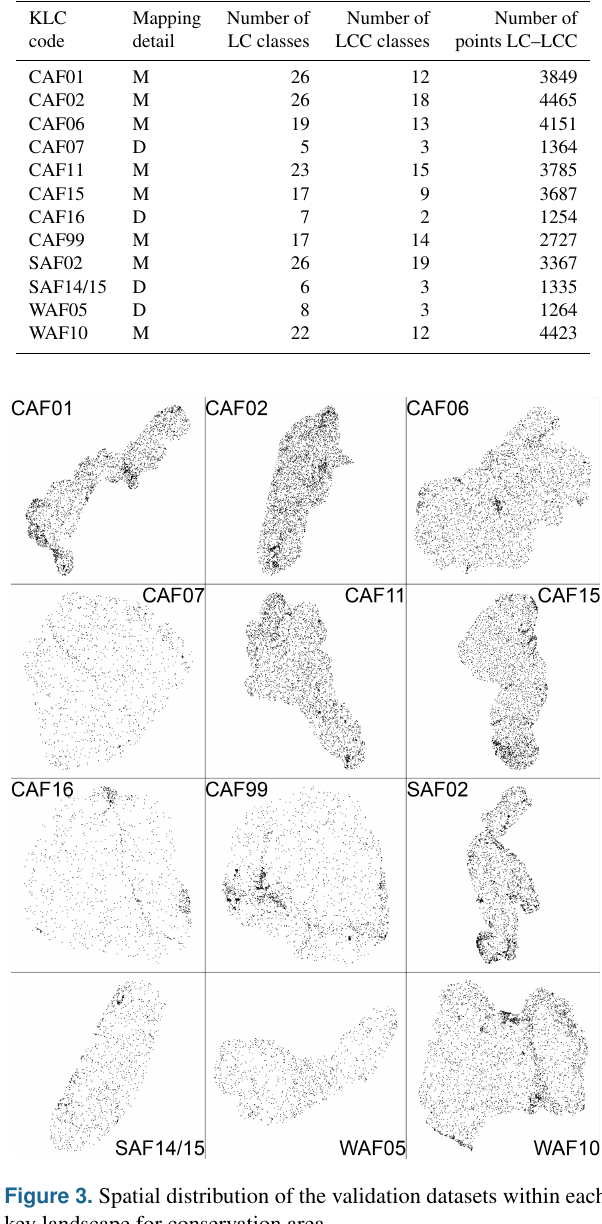
Table 3. Validation dataset attributes.